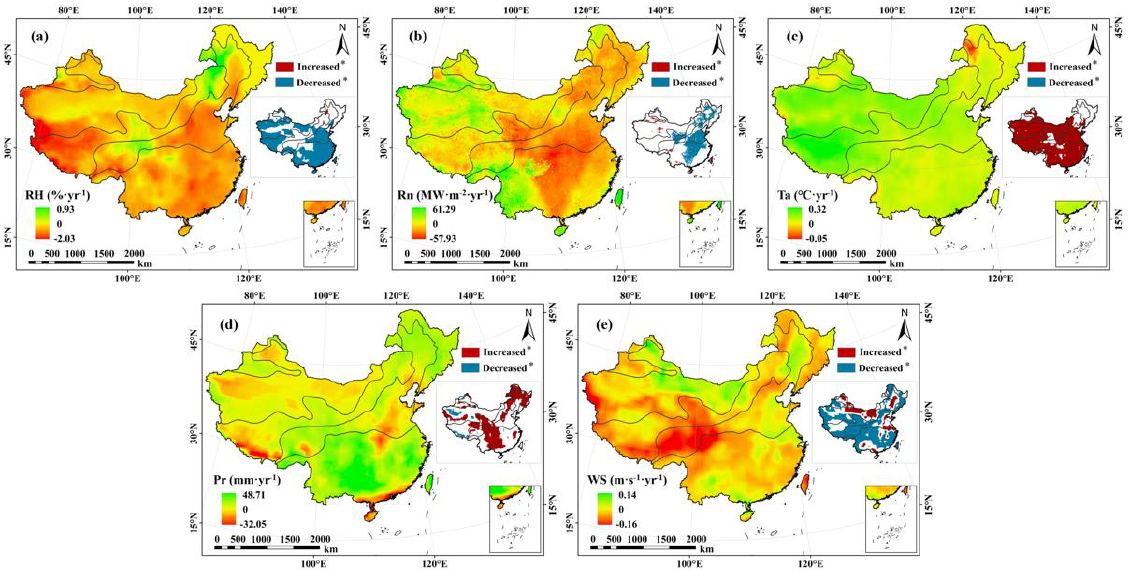
Figure 8. Spatial distribution of trend for each climatic variable across China from 2001 to 2021. ( a ) Relative Humidity (RH, units: % · yr − 1 ); ( b ) Net radiation (Rn, units: MW · m − 2 · yr − 1 ); ( c ) Average temperature (Ta, units: ◦ C · yr − 1 ); ( d ) Precipitation (Pr, units: mm · yr − 1 ); ( e ) Wind Speed (WS, units: m · s − 1 · yr − 1 ). Increased* Decreased*: indicates the regions of significant increase or decrease ( p < 0.05). Figures 9 and 10 represent the spatial distribution of the correlation coefficients for GPP and WUE with each climatic factor. At the national scale, the average correlation coefficients of RH, Rn, Ta, Pr, and WS with GPP were − 0.18, − 0.06, 0.33, 0.19, and − 0.16, respectively. Ta had the largest correlation coefficient with GPP and the trend was very consistent, as seen in the change curves of GPP and Ta over the period 2001 – 2021 (Figure